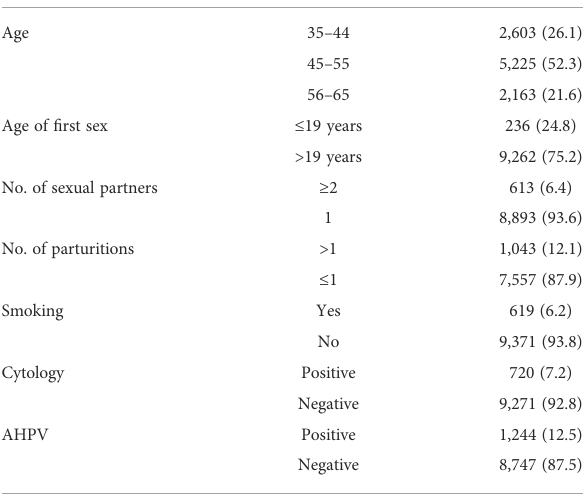
TABLE 1 The baseline characteristics of the 9,991 women with both LBC and AHPV test